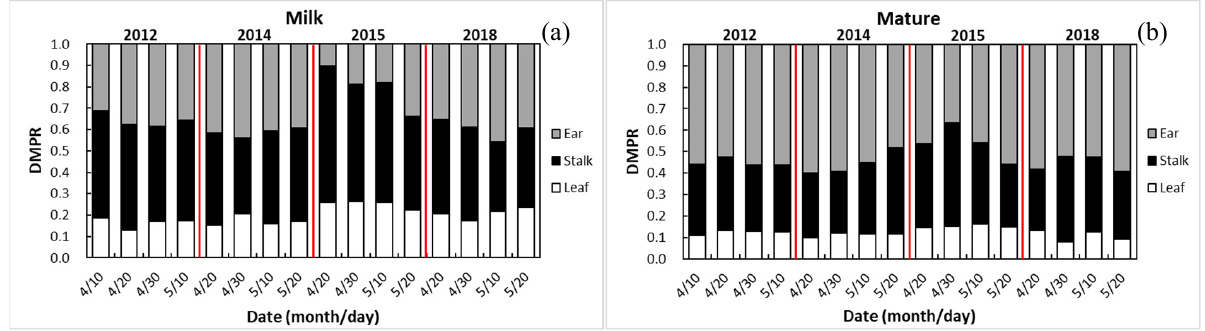
Figure 9. DMPRs at milk stage and at maturity in leaves, stalk, and ears of maize sown on different dates: ( a ) Milk, ( b ) Mature.